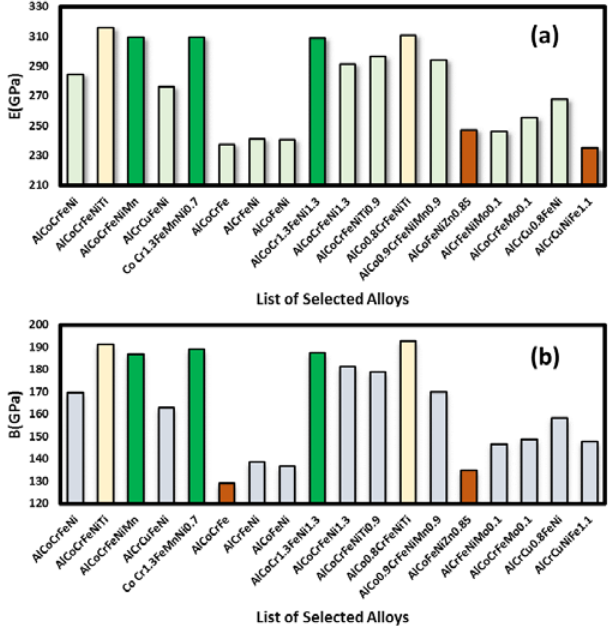
Figure 5. ( a ) Elastic constants ( E ) and ( b ) Bulk modulus ( B ) for selected alloys. Alloys shown in green bar are titanium free but elastic constants are not very different from titanium-based alloys (shown in yellow bar). Red bars are for low performance alloys.